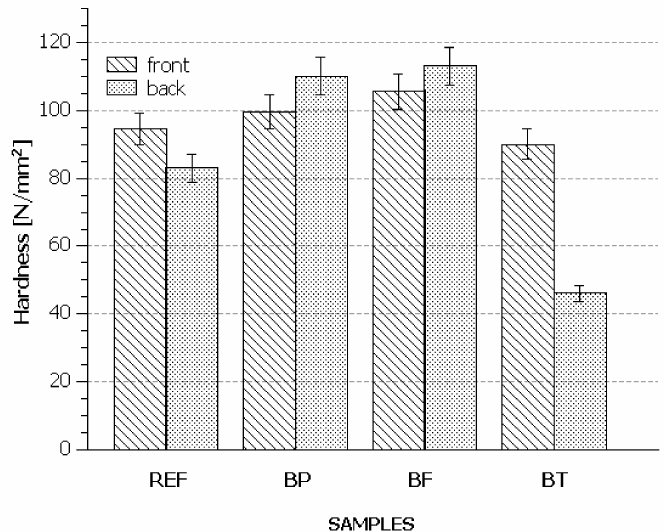
Figure 17. Hardness of VE (REF) sample and VE composites reinforced with basalt powder (BP), basalt fibre (BF) and basalt textile